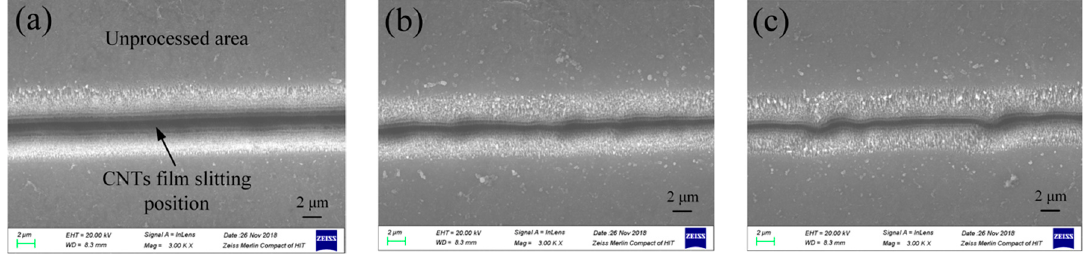
Figure 10. Different laser scanning speeds of the cutting morphology of the CNT film ( a ) v = 0.1 mm/s; ( b ) v = 0.5 mm/s; and ( c ) v = 1.0 mm/s.